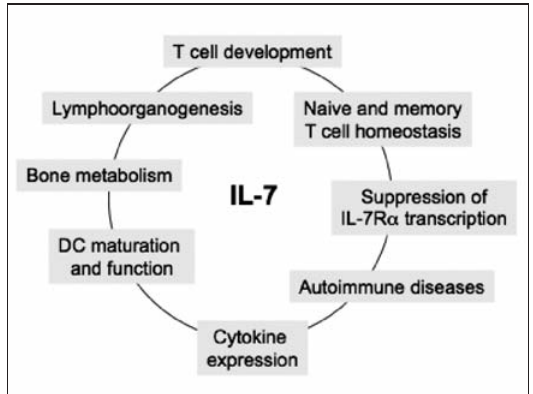
IL-7 has multiple ef- fects on haematopoi- etic cells through in- duction of cytokines, survival and develop- mental signals. IL-7 is critical for the devel- opment of human T cells and for the homeostatic turnover of naïve and memory T cells. It also plays a role in dendritic cell (DC) development, maturation and func- tion. Moreover, it is important in bone metabolism, during lymphoorganogene- sis and can have an influence on autore- active T cells leading to autoimmune dis- eases.